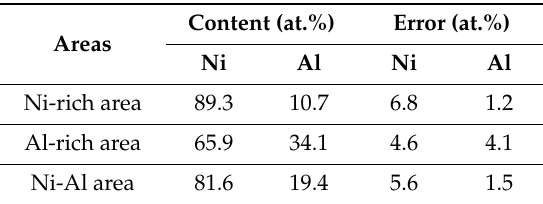
Figure 6. Backscattering result ( a ) and section-distribution result for elements: ( b ) Ni and ( c ) Al for Figure 4f. Table 2. EDS analysis of different areas in Figure 6a.